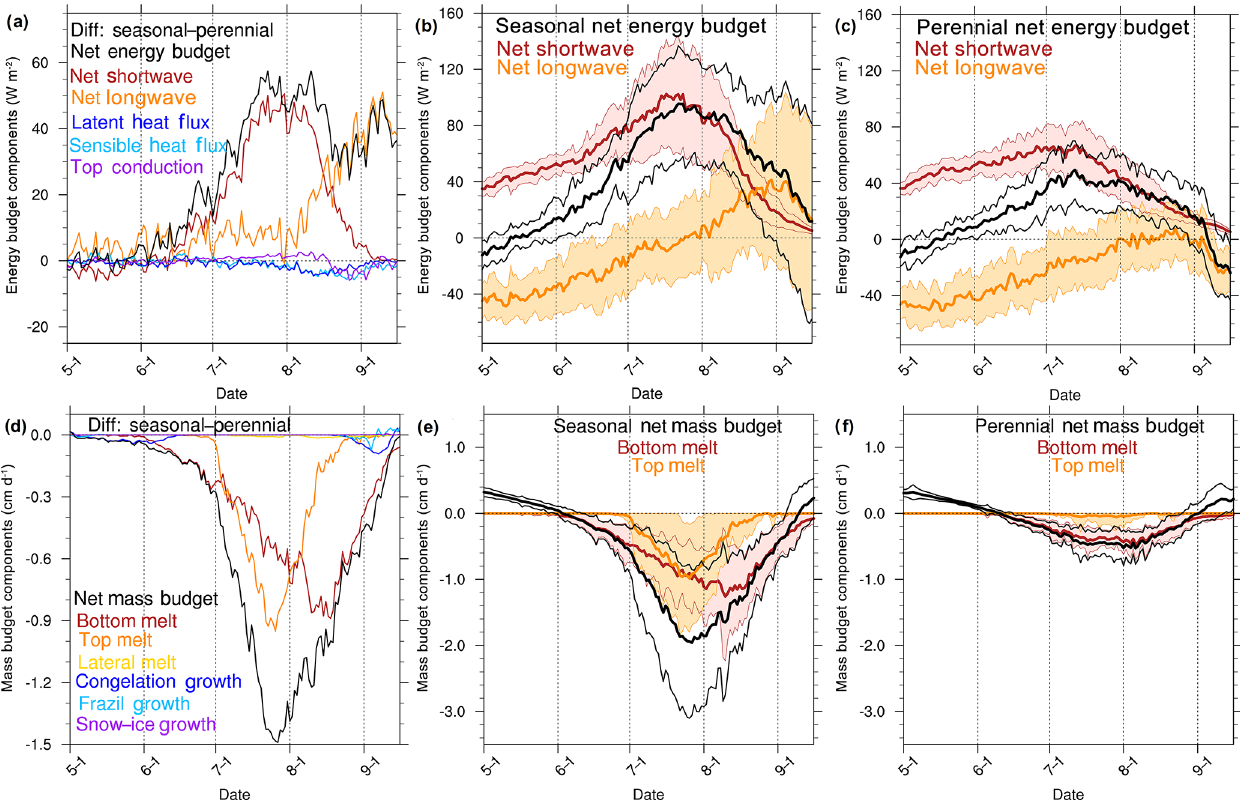
Figure 7. Melt season daily along-track mean surface energy budget (a) and mass budget (d) differences (seasonal tracks minus perennial tracks). The ensemble mean (solid) and ± 1 standard deviation envelope (shaded) are shown for the components with the largest differences for the energy budget (b, c) and mass budget (e, f) . Components of the energy budget include net (black), net shortwave (red), net longwave (orange), latent heat flux (dark blue), sensible heat flux (light blue), and top conductive flux (purple). Components of the mass budget include net (black), bottom melt (red), top melt (orange), lateral melt (gold), congelation growth (dark blue), frazil growth (light blue), and snow–ice growth (purple). The melt season shown here corresponds to 1 May to 15